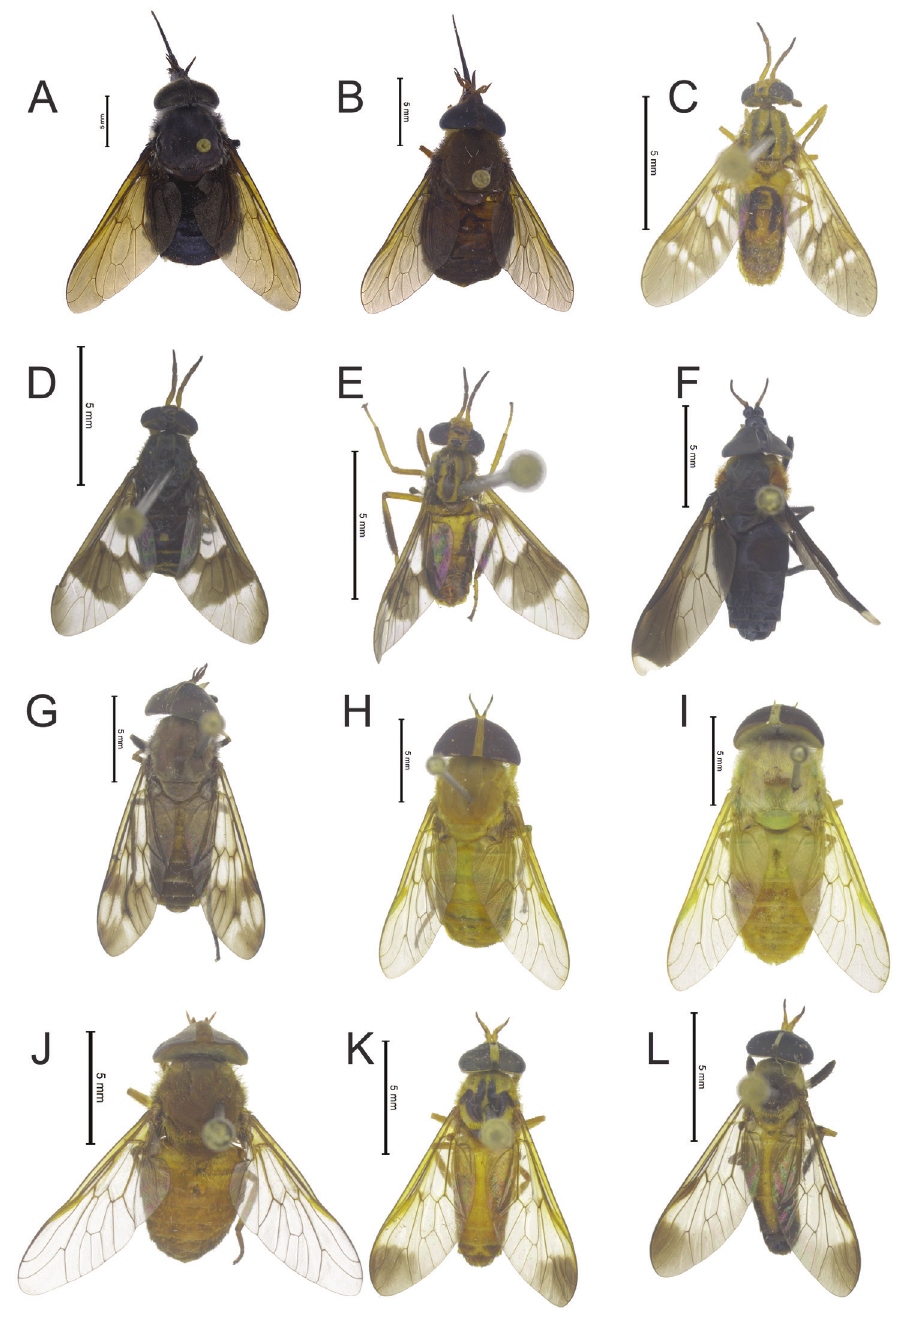
Figure 11. A Fidena auripes (Ricardo) B Pityocera cervus (Wiedemann) C Chrysops ecuadorensis Lutz D Chrys- ops incisus Macquart E Chrysops sp. F Bolbodimyia brunneipennis Stone G Catachlorops amazonicus Henriques & Gorayeb H Chlorotabanus flagellatus Krolow & Henriques I Chlorotabanus inanis (Fabricius) J Cryptoylus cauri Stone K Diachlorus curvipes (Fabricius) L Diachlorus fuscistigma Lutz. Photos by Augusto